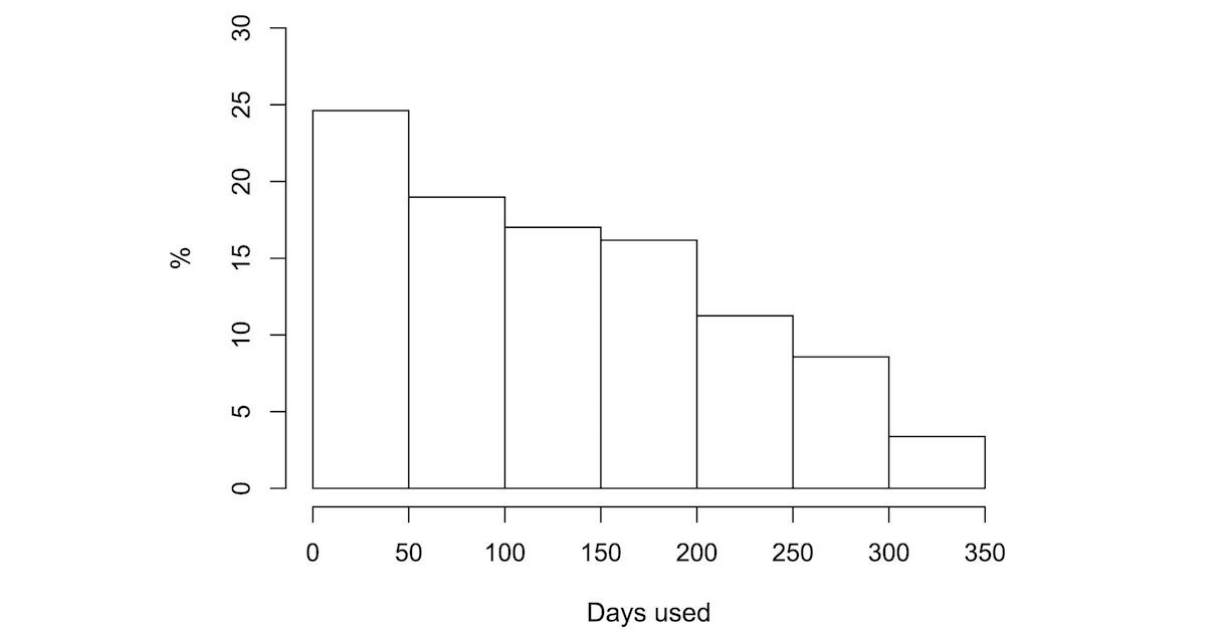
Figure 1. Distribution of participants’total number of days of activity tracker